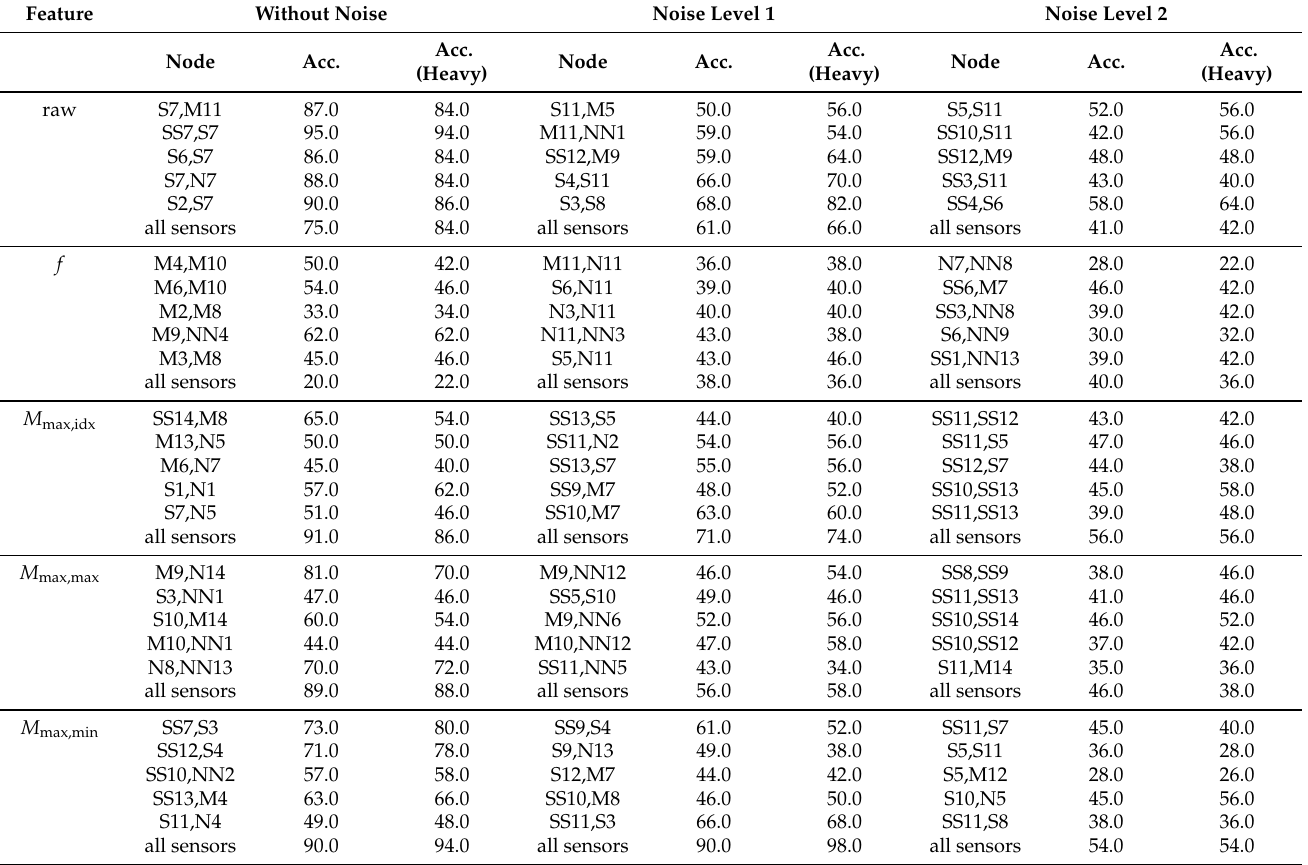
Table 6. Results on the temperature test dataset sorted by the best five sensor pairs of each feature from Table 4 based on displacement in the z direction. Crossings at different temperatures were used as the test dataset (not equal to 20°C). The table is structured like Table